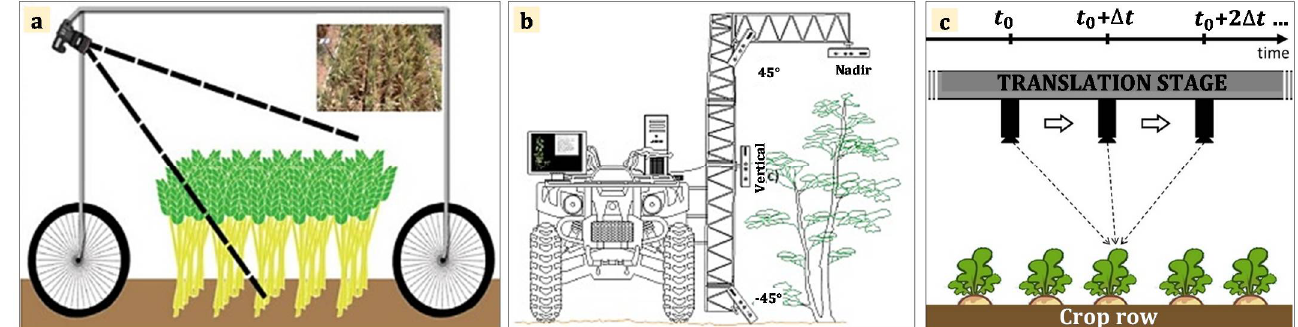
Figure 1. Example of research works for estimation of plant density from low-altitude imagery and different viewing angle showing ( a ) detection and analysis of wheat spikes from oblique digital images using CNN [42], ( b ) biomass estimation using Kinect sensors from different viewing angles in order to match the best viewing angle based on poplar seedling geometry [43], and ( c ) in-field crop row phenotyping estimation from 3D modeling derived by SfM from top-view RGB images [44].